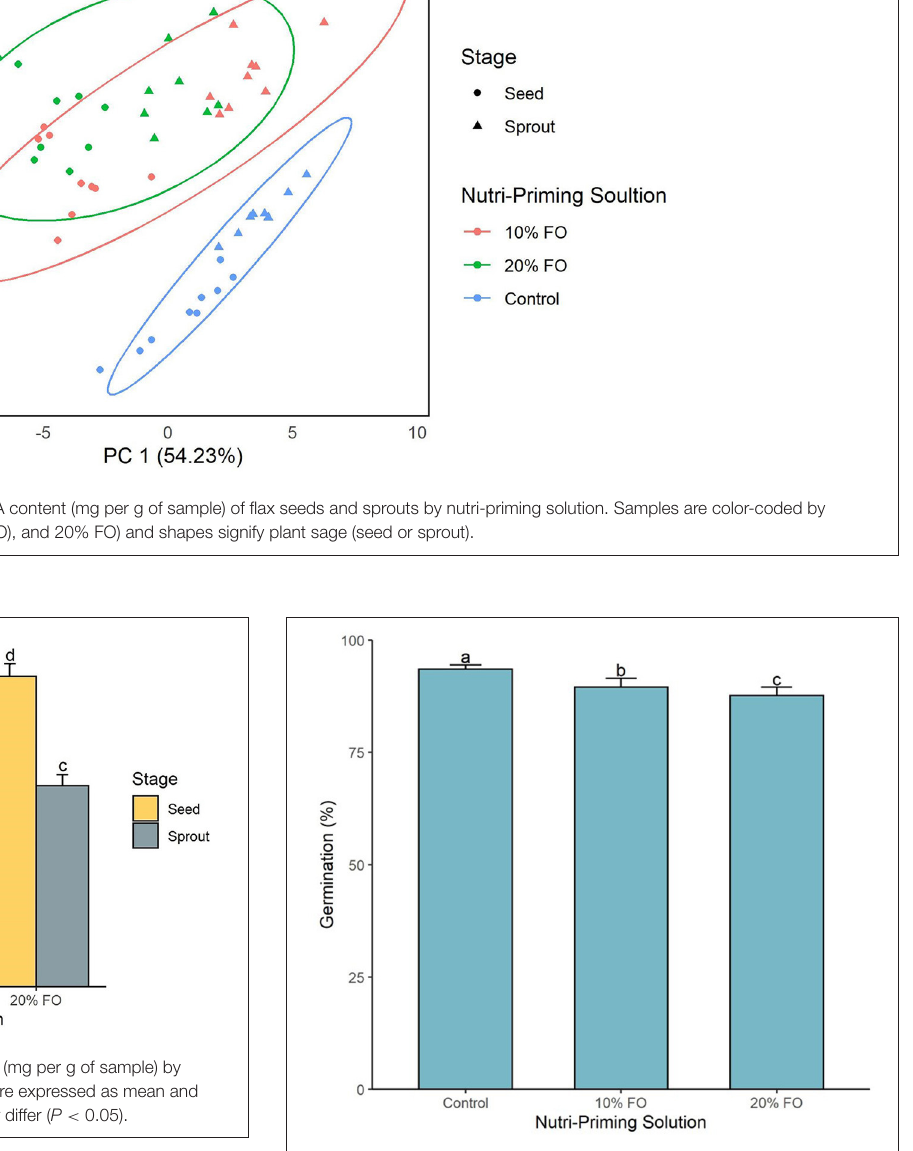
FIGURE 3 | Germination percentage of sprouts by nutri-priming solution. Values are expressed as mean and standard error. Means without a common letter differ ( P <